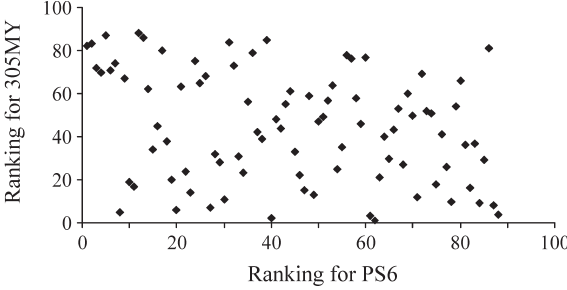
Figure 6 - Estimated breeding values across lactation of the top five sires (SM1-SM5) with more than 25 daughters ranked for 305-day milk yield